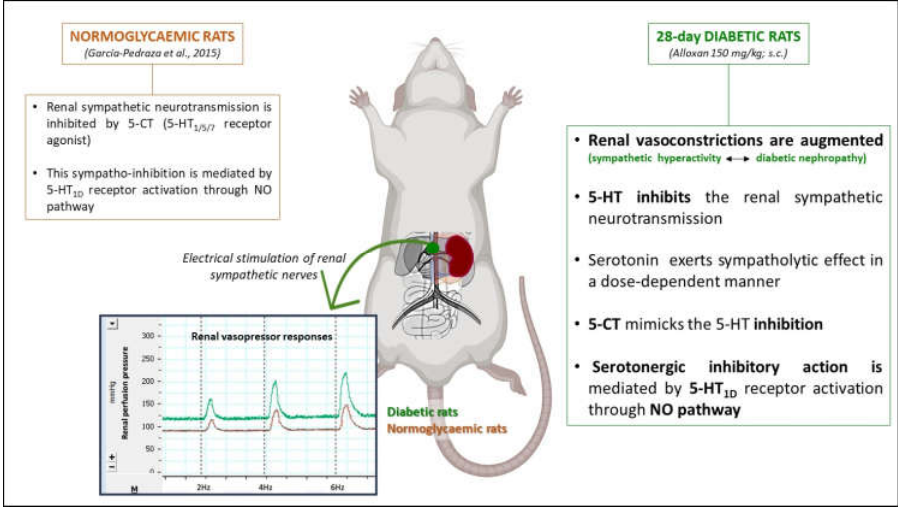
Figure 7. Scheme summarizing the main outcomes in 5-HT modulation of the renal sympathetic neurotransmission in normoglycaemic and diabetic animals.